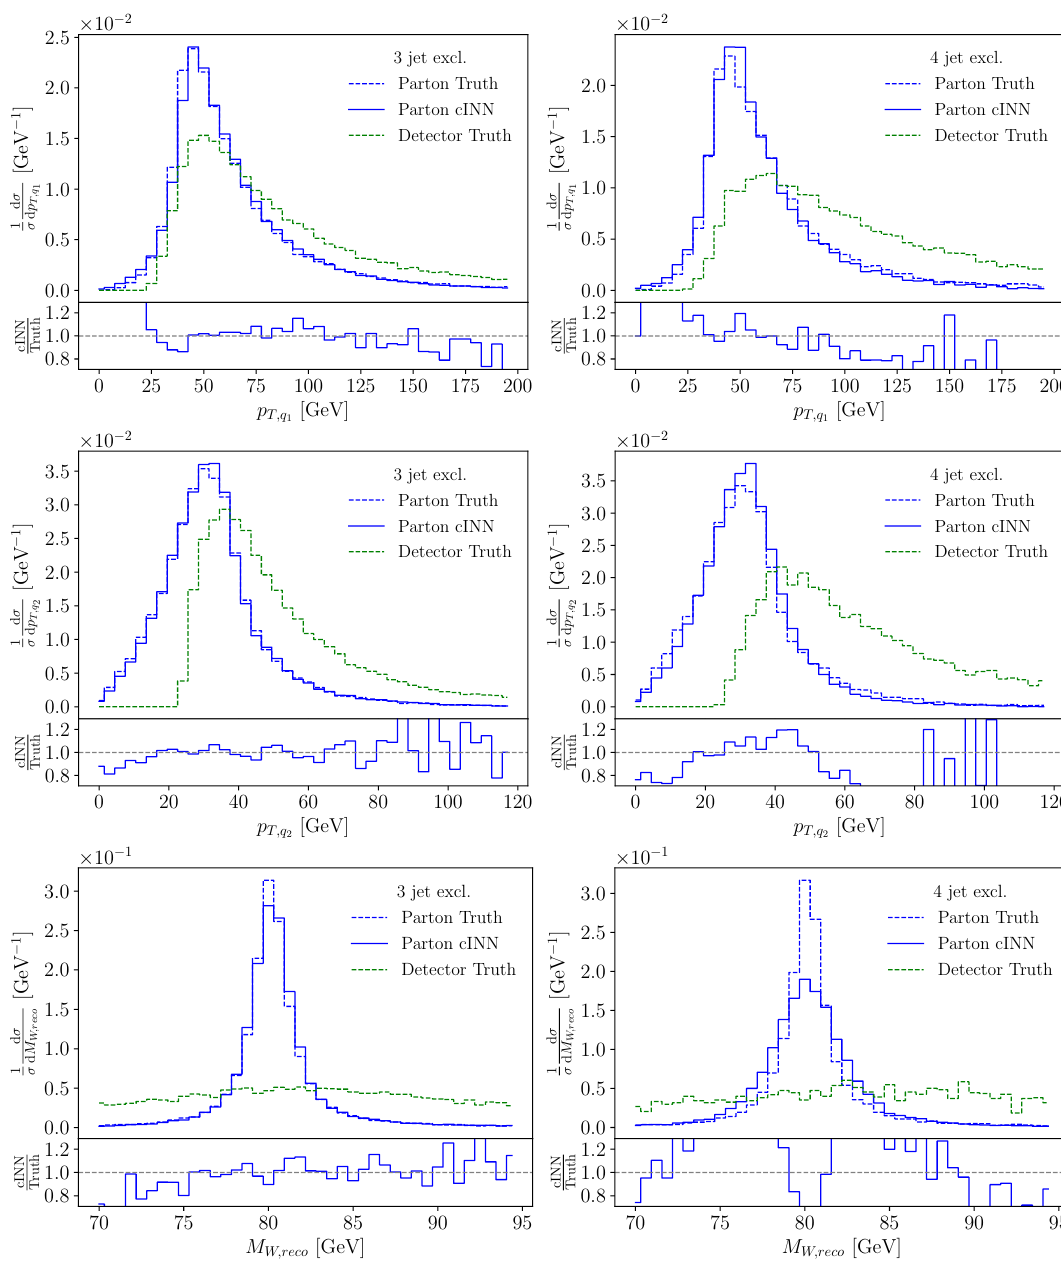
Figure 8: cINNed p and m distributions. Training and testing events include T , q W ,reco exactly three (left) and four (right) jets from the data set including